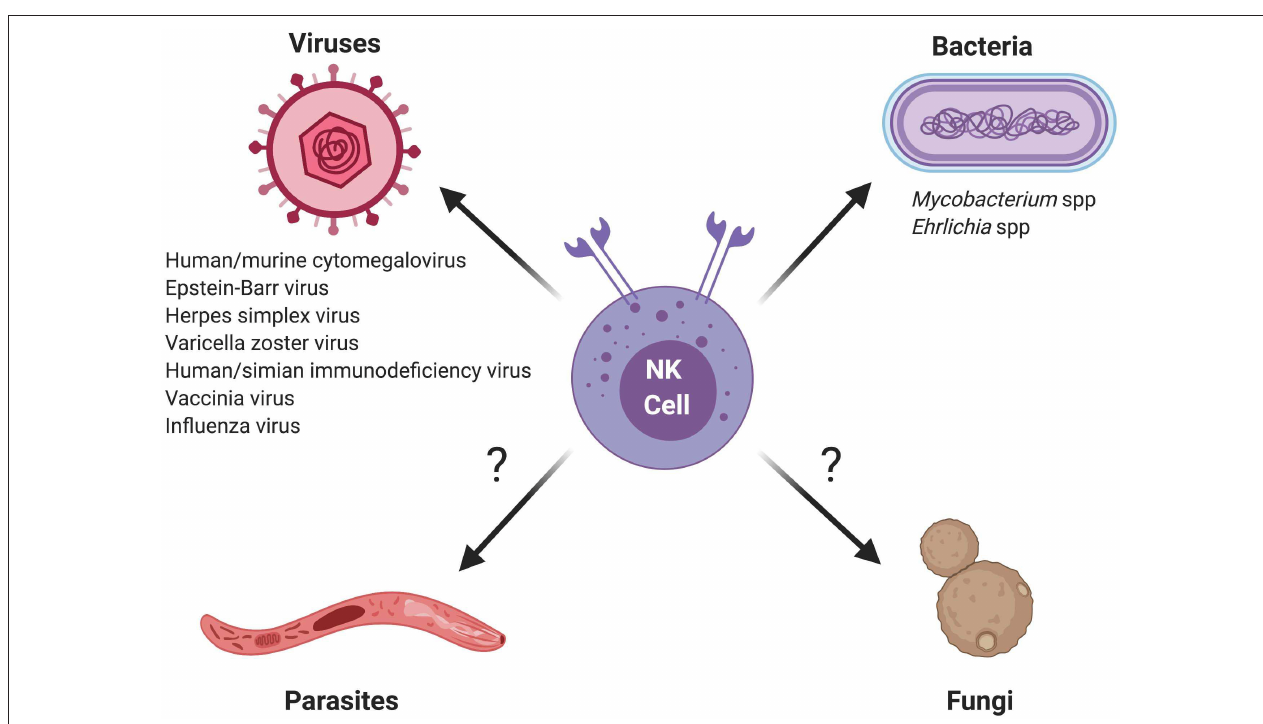
FIGURE 1 | Schematic of memory and memory-like NK cell responses against different classes of microbial pathogens. Question marks indicate eukaryotic pathogens for which memory or memory-like responses by NK cells require further investigation.